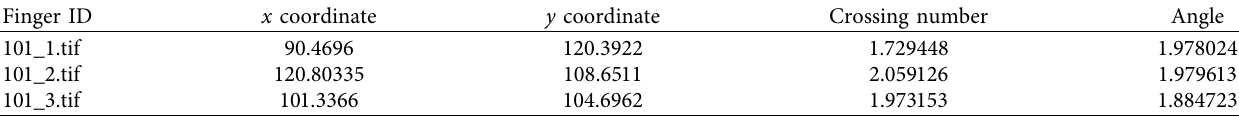
Table 3: Feature vector representation of the first three impressions of fingers